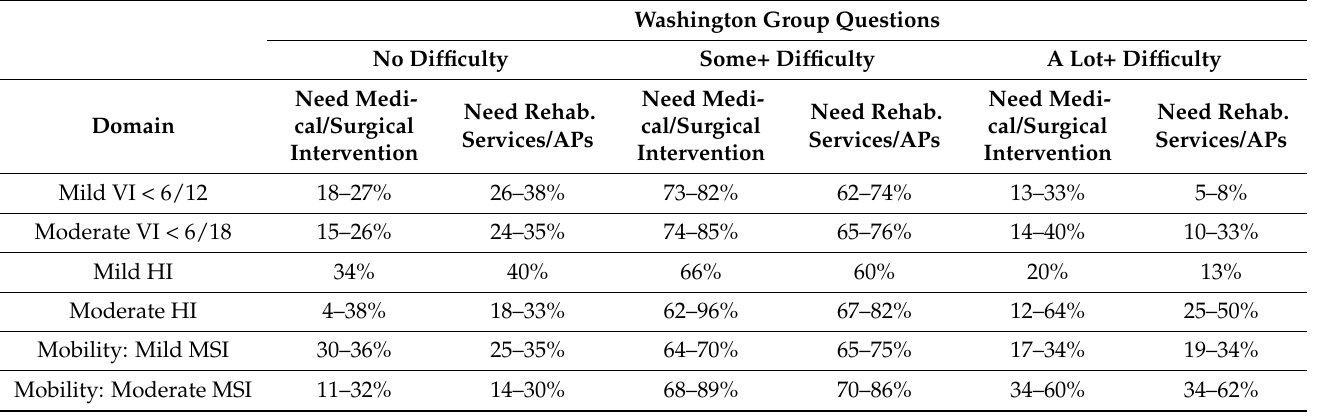
Table 3. Proportion of participants assessed to have a clinical impairment and need interventions* who were identified as having functional difficulties by Washington Group